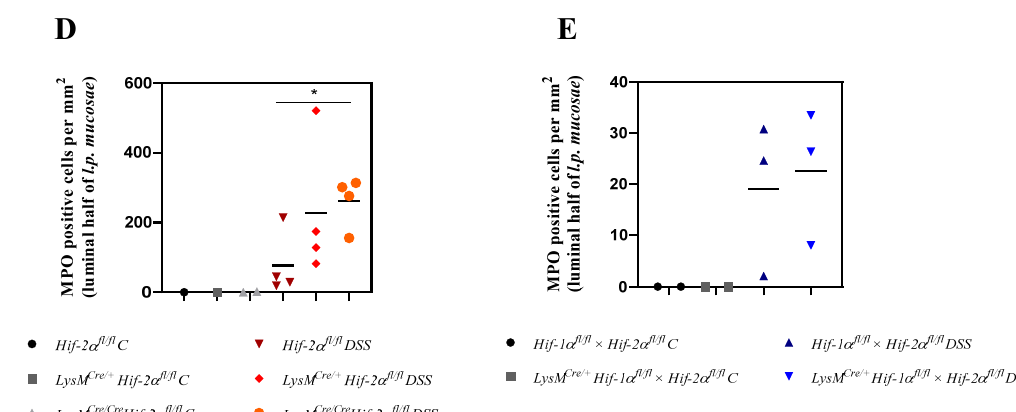
Figure 6. Neutrophils without functional HIF-2 α showed a higher migration pattern compared to wildtype cells. Exemplary presentation of MPO-stained colon tissue sections of ( A ) Hif-2 α fl / fl , LysM Cre / + Hif-2 α fl / fl and LysM Cre / Cre Hif-2 α fl / fl animals, and ( B ) Hif-1 α fl / fl × Hif-2 α fl / fl and LysM Cre /+ Hif-1 α fl / fl